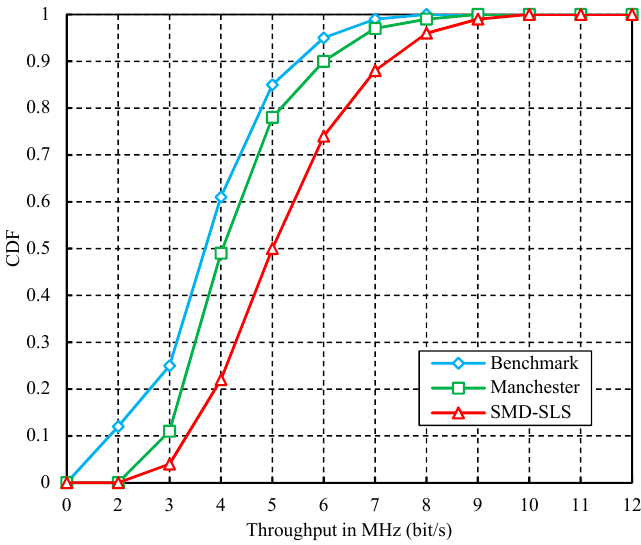
Figure 7. Average throughput vs cumulative density function (CDF) deployed with seven cells.